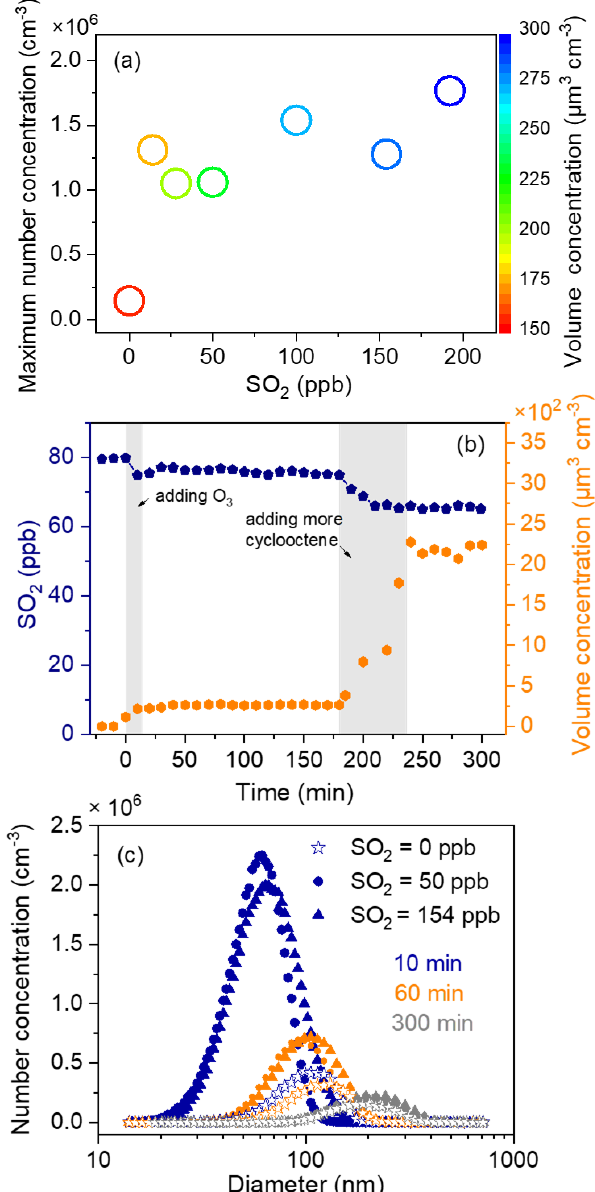
Figure 1. Particle formation from the ozonolysis of cyclooctene under various SO 2 conditions. (a) Maximum particle number con- centration as a function of initial SO 2 level. Circle color represents particle volume concentration. (b) Temporal profiles of SO 2 con- centration and particle volume concentration. (c) Size distributions of aerosol particles formed with various SO 2 concentrations at 10, 60, and 300min after the initiation of cyclooctene